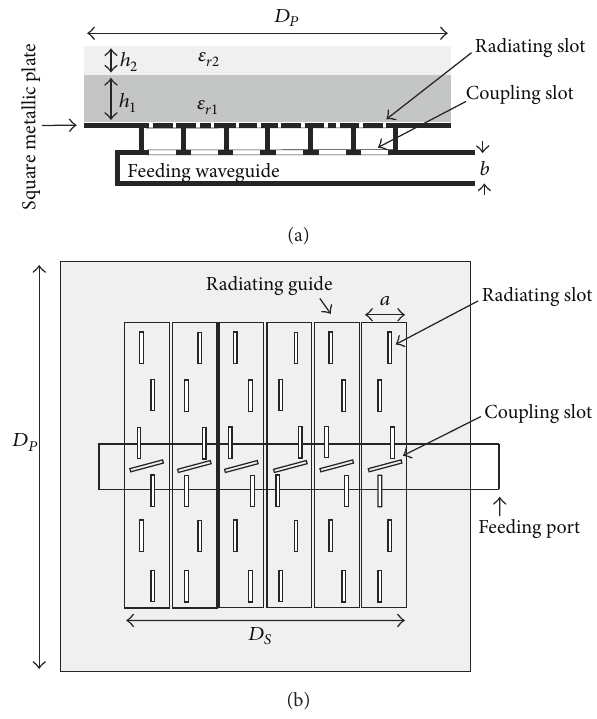
Figure 1: Array geometry: (a) side view; (b) top